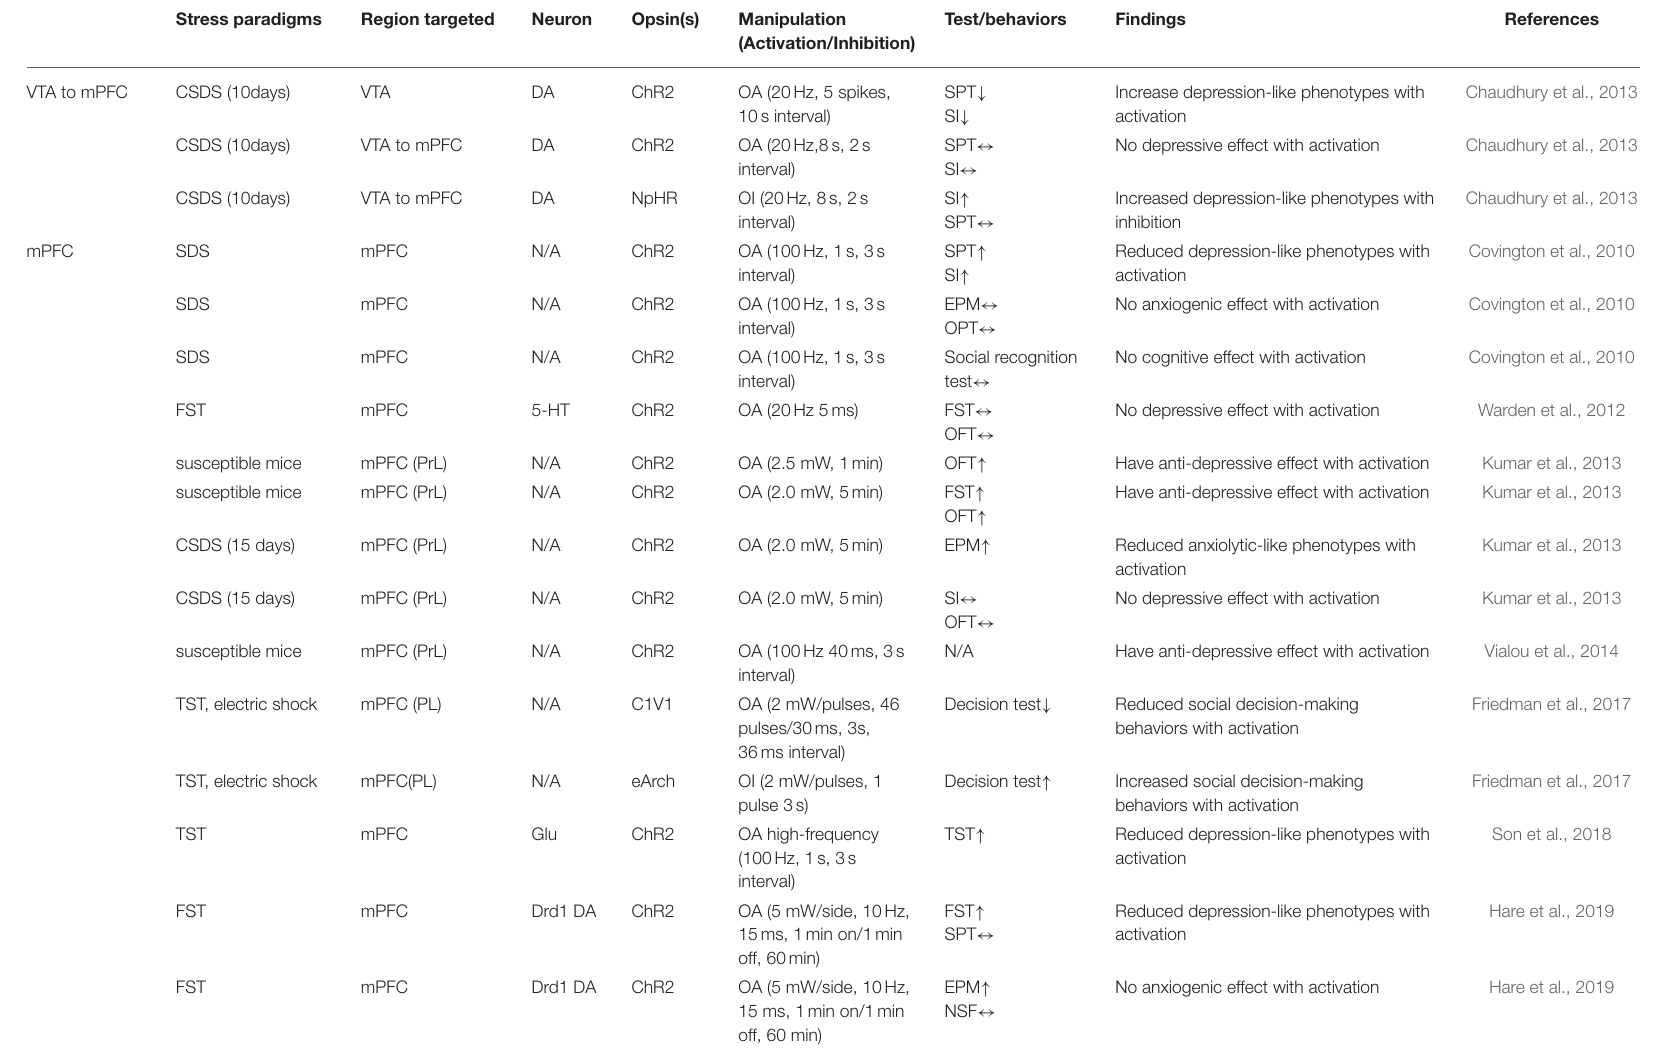
TABLE 1 | The underlying circuits of stress-induced mood disorders and its influencing